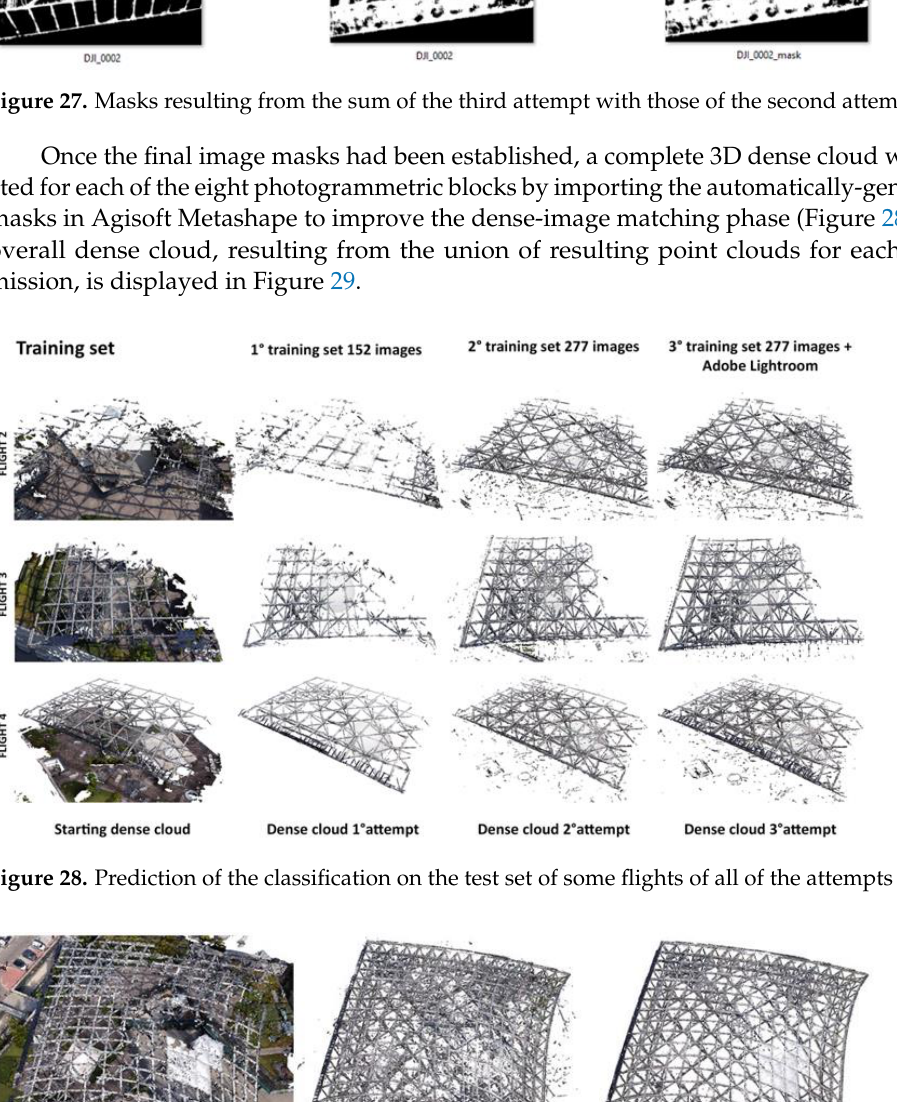
Figure 29. From left to right: dense cloud obtained with no prior image masking; dense cloud ob- tained via CNN-based image masking; dense cloud via the final rectification process.